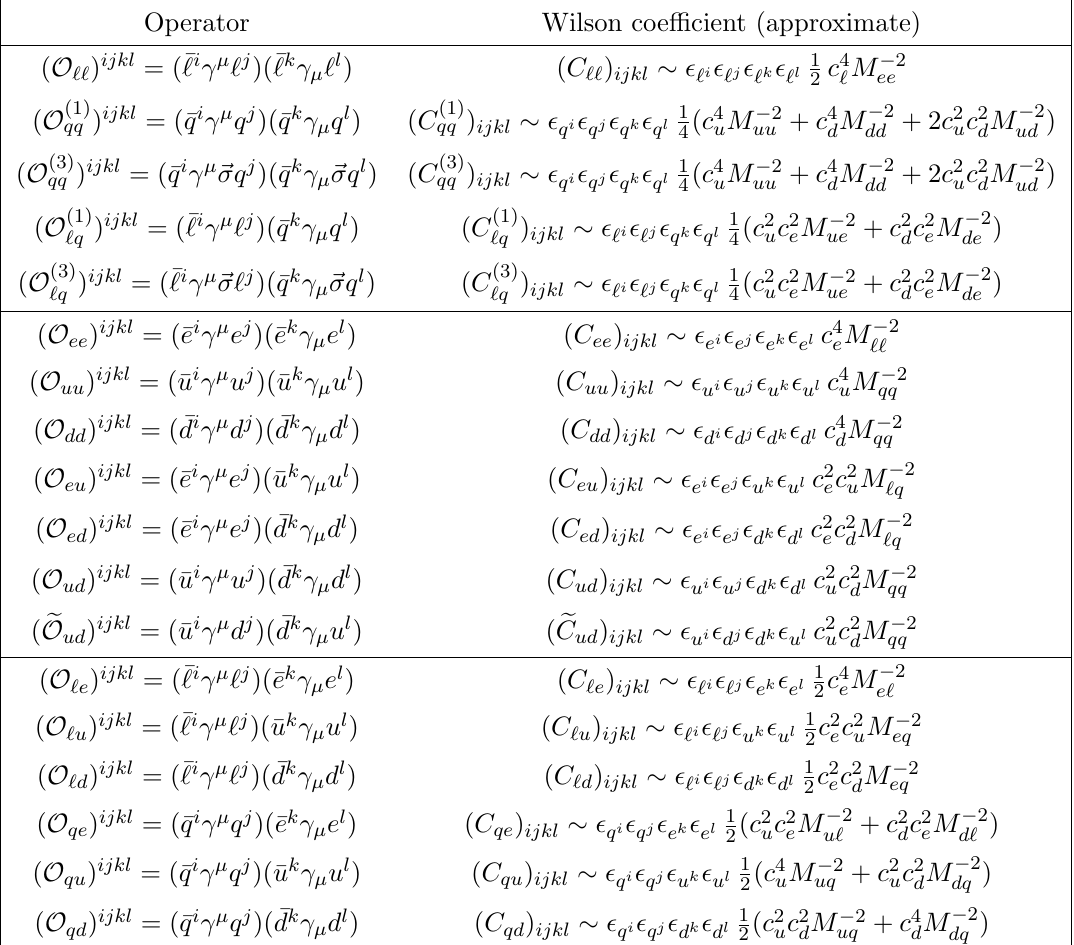
Table 5. Four-fermion operators and their Wilson